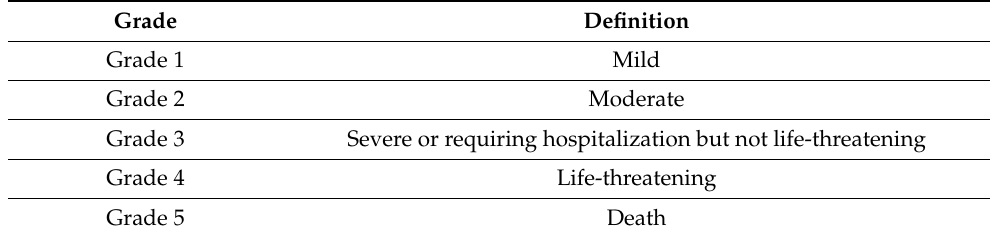
Table 2. Categorization of immune-related adverse events (irAEs) based on severity.